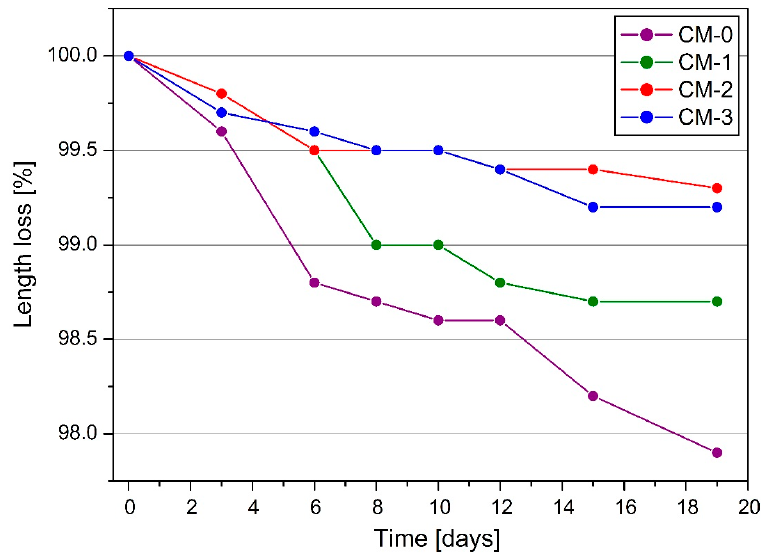
Figure 6. The average decrease in sample length on individual days. Table 5. The average values of the mass loss of the samples over time and the standard deviation.